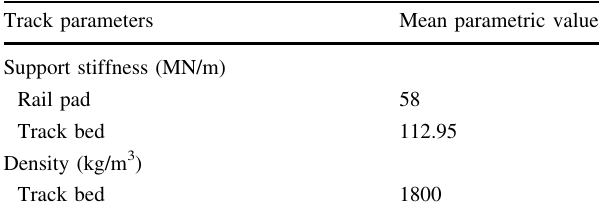
Table 1 Parametric characteristics of the tracks Track parameters Mean parametric value Support stiffness (MN/m)